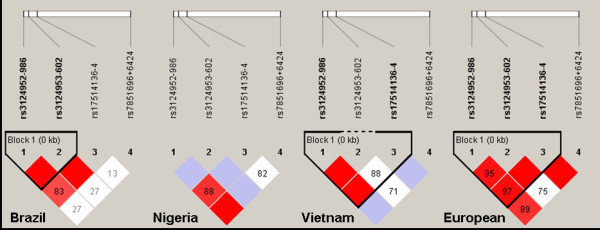
Haploview plot illustrating the linkage disequilibrium of theFCN2gene variants in different ethnicities. At the top, the SNPs are shown according to their succession from the start of the translation of the FCN2 gene. Open squares indicate a high degree of LD (LD coefficient D’ = 1) between pairs of markers. Numbers indicate the D’ value expressed as a percentile. Red squares indicate pairs in strong LD with LOD scores LD ≥ 34; pink squares, D’ = 1 with LOD ≤ 2; white squares, D’ < 1 with LOD ≤ 1.